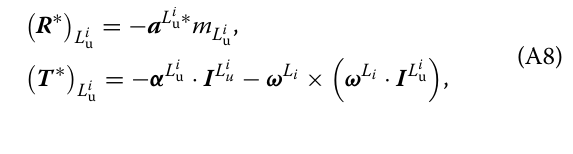
Table 1 Partial velocity and partial angular velocity of the components in 3UPS/S Component Partial velocity Partial velocity Subscript range Moving platform W